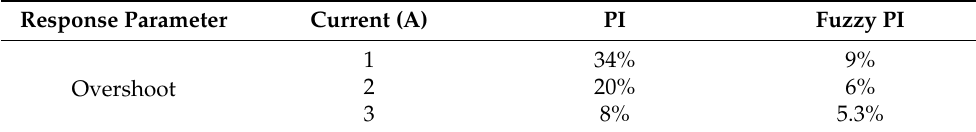
Table 5. Overshoot of PI and fuzzy PI controllers at different step